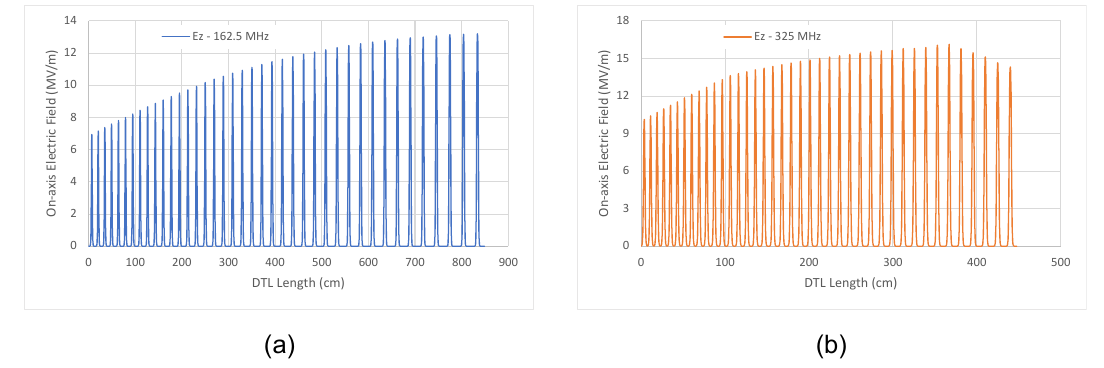
Figure 13. Ez-field distributions calculated by the SUPERFISH code ( a ) 162.5 MHz design, ( b ) 325 MHz